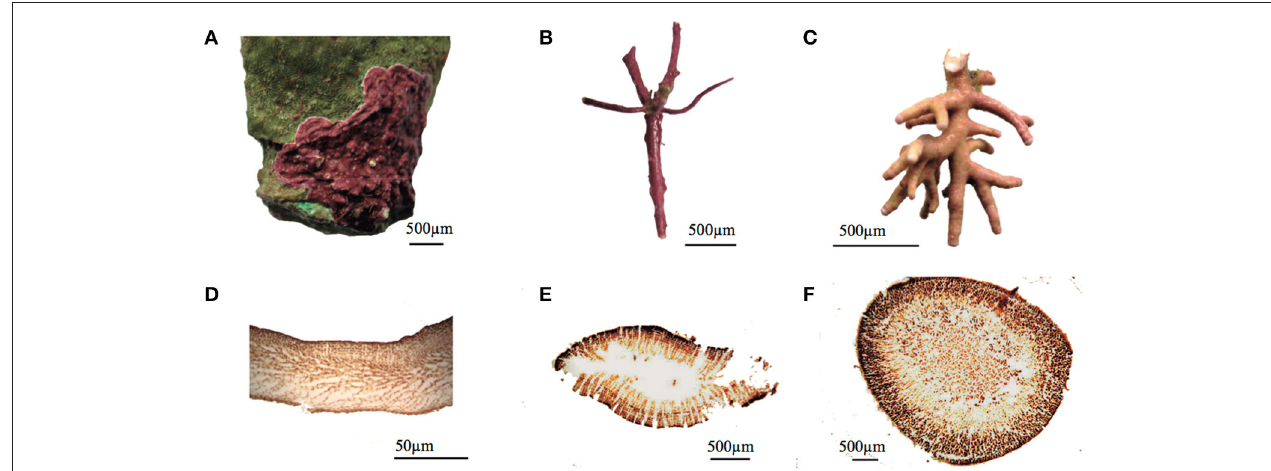
FIGURE 1 | Images of the three coralline algae (Rhodophyta) characterized in this study. ( A ) The crustose coralline alga (CCA), Lithothamnion sp. growing on some dead coral skeleton of the genus Orbicella . ( B ) The articulated alga Amphiroa tribulus . ( C ) The rhodolith forming species belonging to the genus Neogoniolithon sp. (D–F) show a microscopic cross section of their respective thalli.